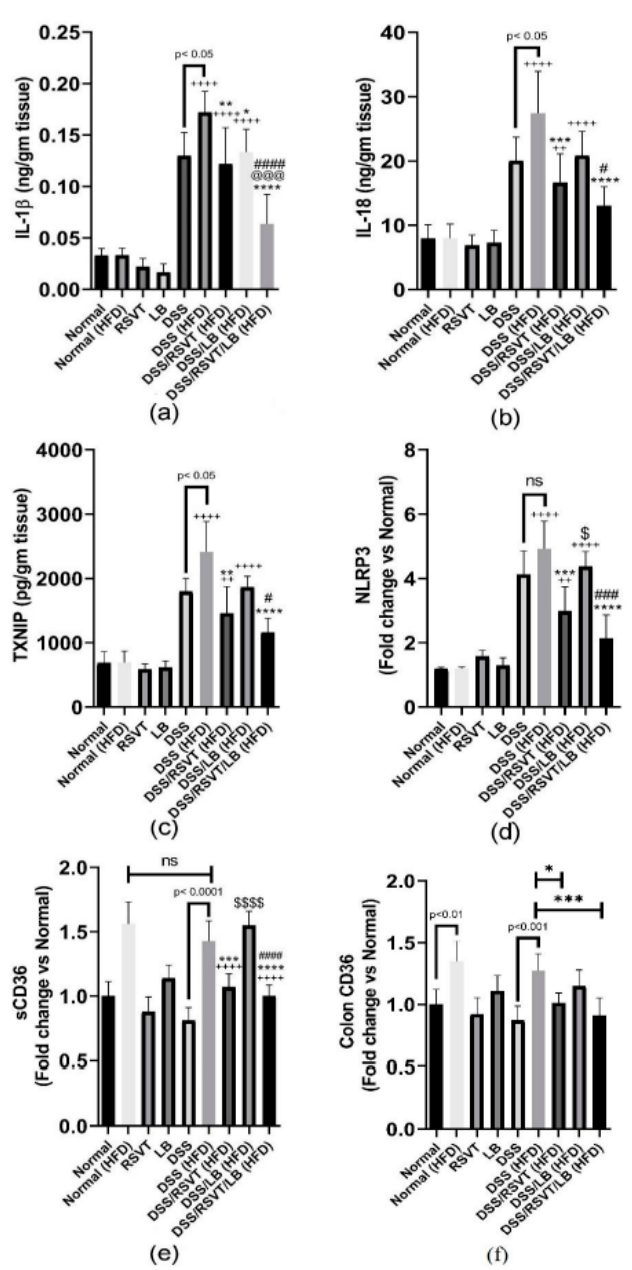
Figure 9. Effect of rosuvastatin (RSVT), Lactobacillus (LB), and their combined therapy on ( a ), IL-1 β ; ( b ), IL-18; ( c ), TXNIP; ( d ), NLRP3; ( e ), sCD36; and ( f ), colon CD36. ++, p < 0.01 vs. Normal (HFD); ++++, p < 0.0001 vs. Normal (HFD); *, p < 0.05 vs. DSS (HFD); **, p < 0.01 vs. DSS (HFD); ***, p < 0.001 vs. DSS (HFD); ****, p < 0.0001 vs. DSS (HFD); #, p < 0.05 vs. DSS/LB (HFD); ###, p < 0.001 vs. DSS/LB (HFD); ####, p < 0.0001 vs. DSS/LB (HFD); @@@, p < 0.001 vs. DSS/RSVT (HFD); $, p < 0.05 DSS/RSVT (HFD) vs. DSS/LB (HFD); $$$$, p < 0.0001 DSS/RSVT (HFD) vs. DSS/LB (HFD); ns, non-significant.